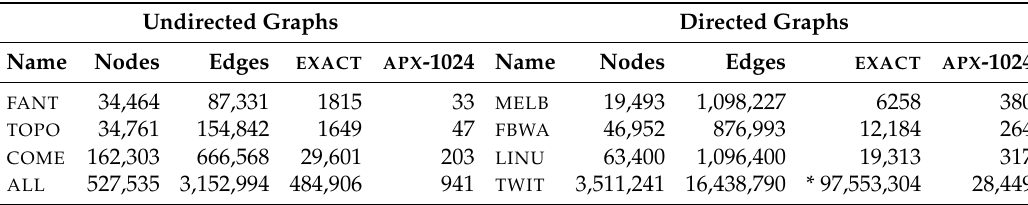
Table 1. A sample of our dataset. For each graph we report the number of nodes, the number of temporal edges, and the running times (in seconds) of EXACT (the cell marked with * is an estimation) and APX -1024 (average among 50 experiments). The running times of APX - h , for any other value of h , t /1024, where t is the running time of APX -1024. can be estimated as h · Undirected Graphs Directed